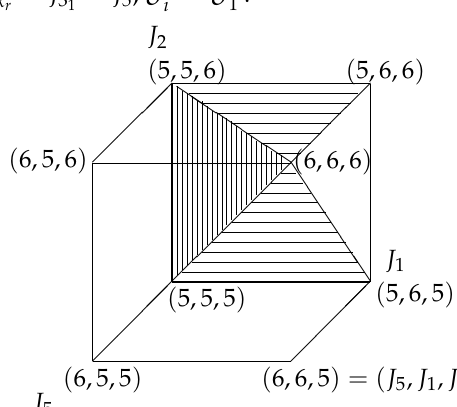
Figure 4. The pyramid PCO{ J k